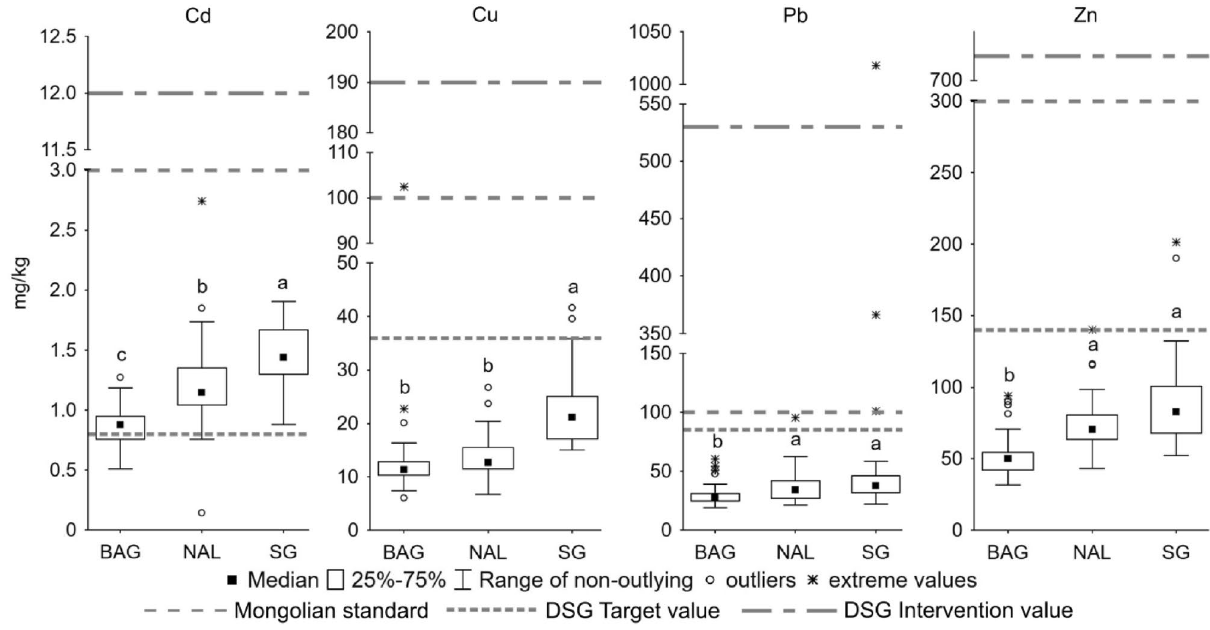
Figure 2. Metal contents (mg/kg) in the urban soils of the coal mining